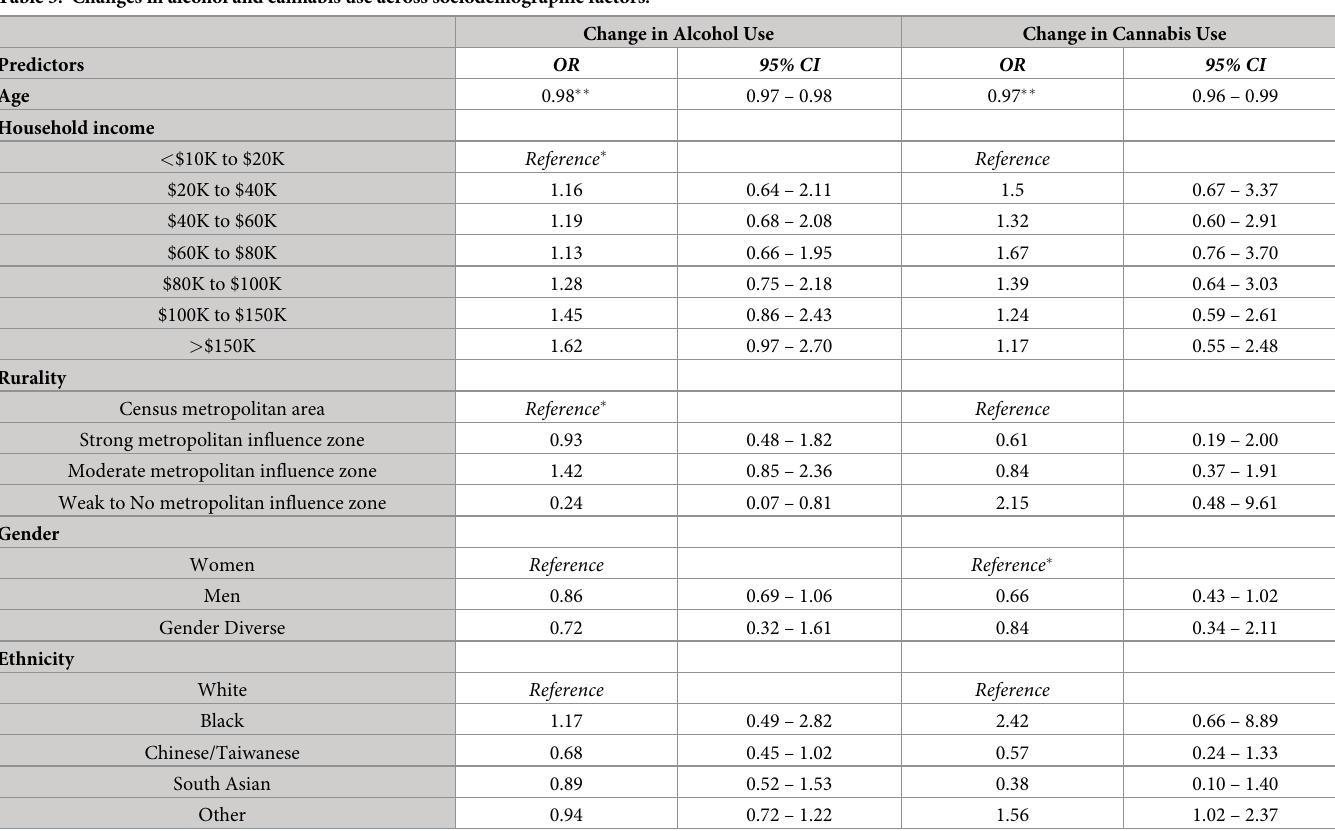
Table 3. Changes in alcohol and cannabis use across sociodemographic